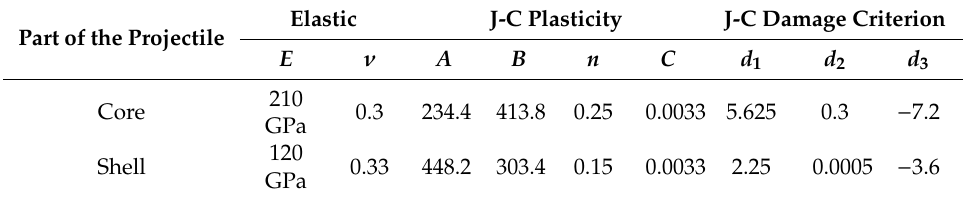
Table 3. Material constants for 1.3964 steel.